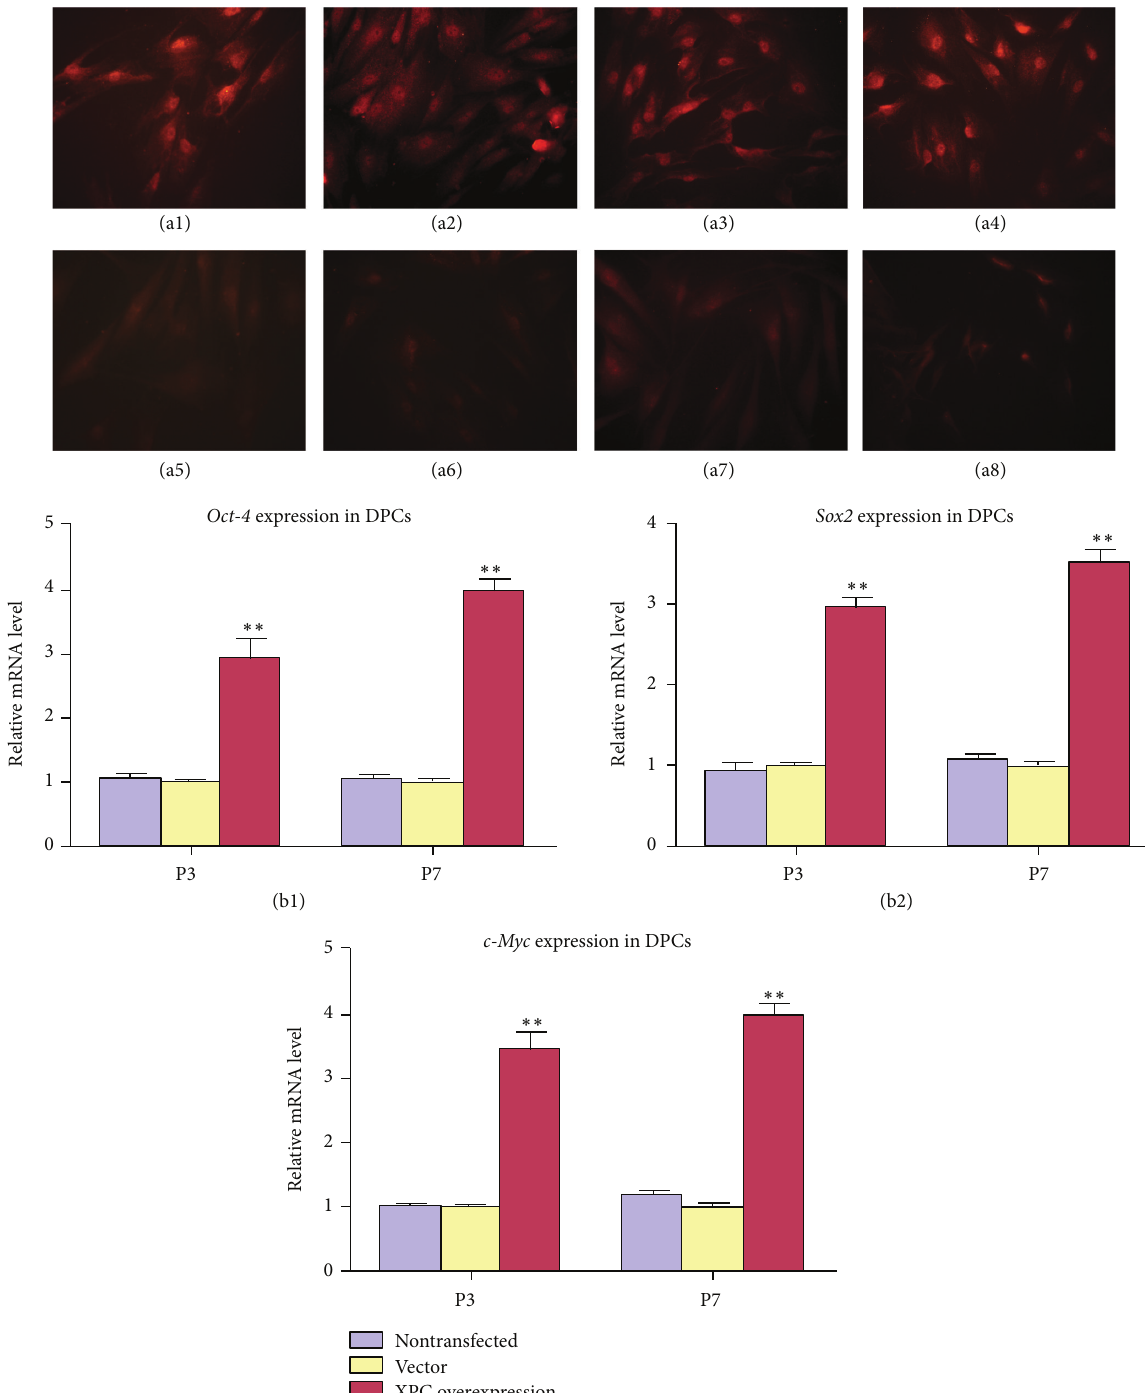
Figure 4: Effect of XPC on the expression of Oct-4, Sox2, and c-Myc in DPCs at various passages. Immunofluorescent staining revealed that XPC (a1), Oct-4 (a2), Sox2 (a3), and c-Myc (a4) were strongly expressed in DPCs with XPC overexpression at P7, mainly located in nucleus and moderately expressed in cytoplasm, whereas XPC (a5), Oct-4 (a6), Sox2 (a7), and c-Myc (a8) were barely detected in DPCs at P7 without transfection. Real-time PCR indicated that the mRNA expression of XPC, Oct-4, Sox2 , and c-Myc was upregulated significantly in DPCs with XPC overexpression at both P3 and P7 compared with vector groups ( ∗∗ 𝑝 < 0.001 ). There is no significant difference between nontransfected group and vector group ( 𝑝 > 0.05 )